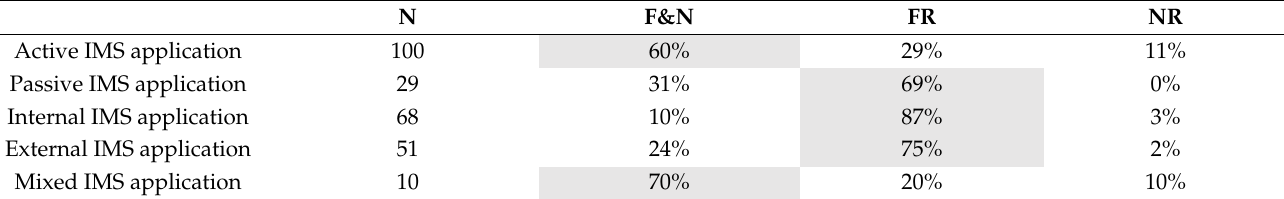
Table 14. Databases analyses of the ideas